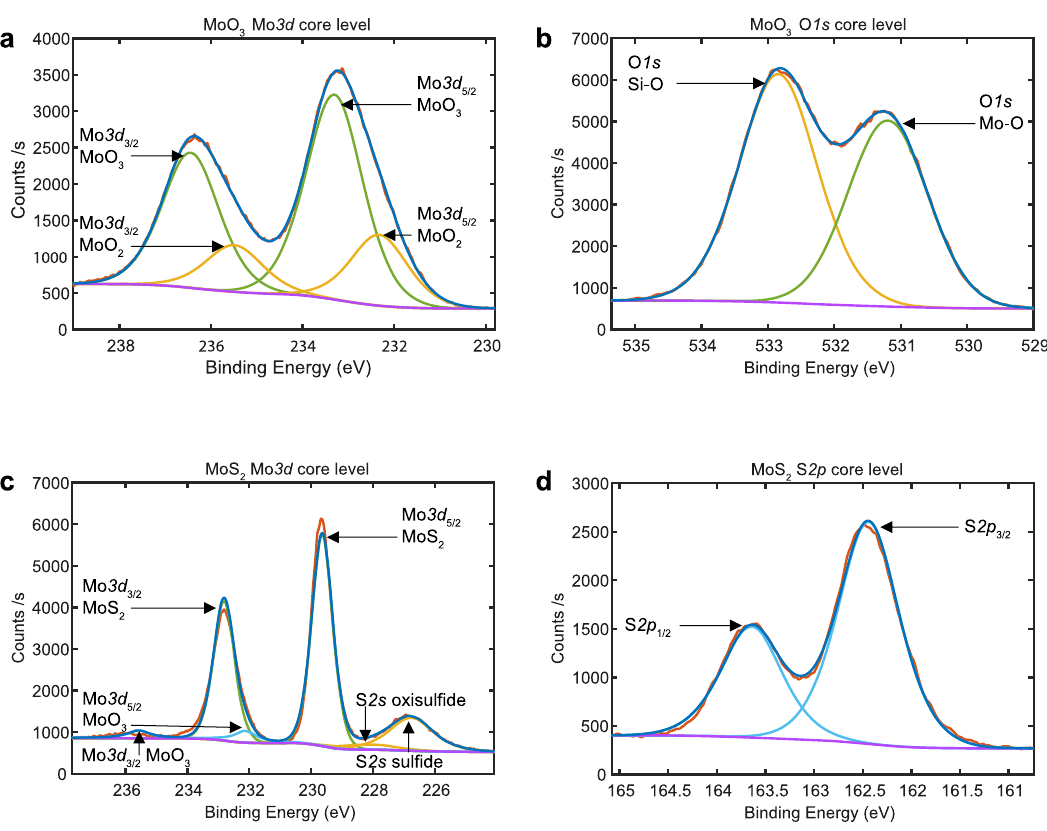
Fig. 2 XPS analysis of the MoO 3 fi lm. a Mo 3d , b O 1s and the MoS 2 c Mo 3d and d S 2p core levels.